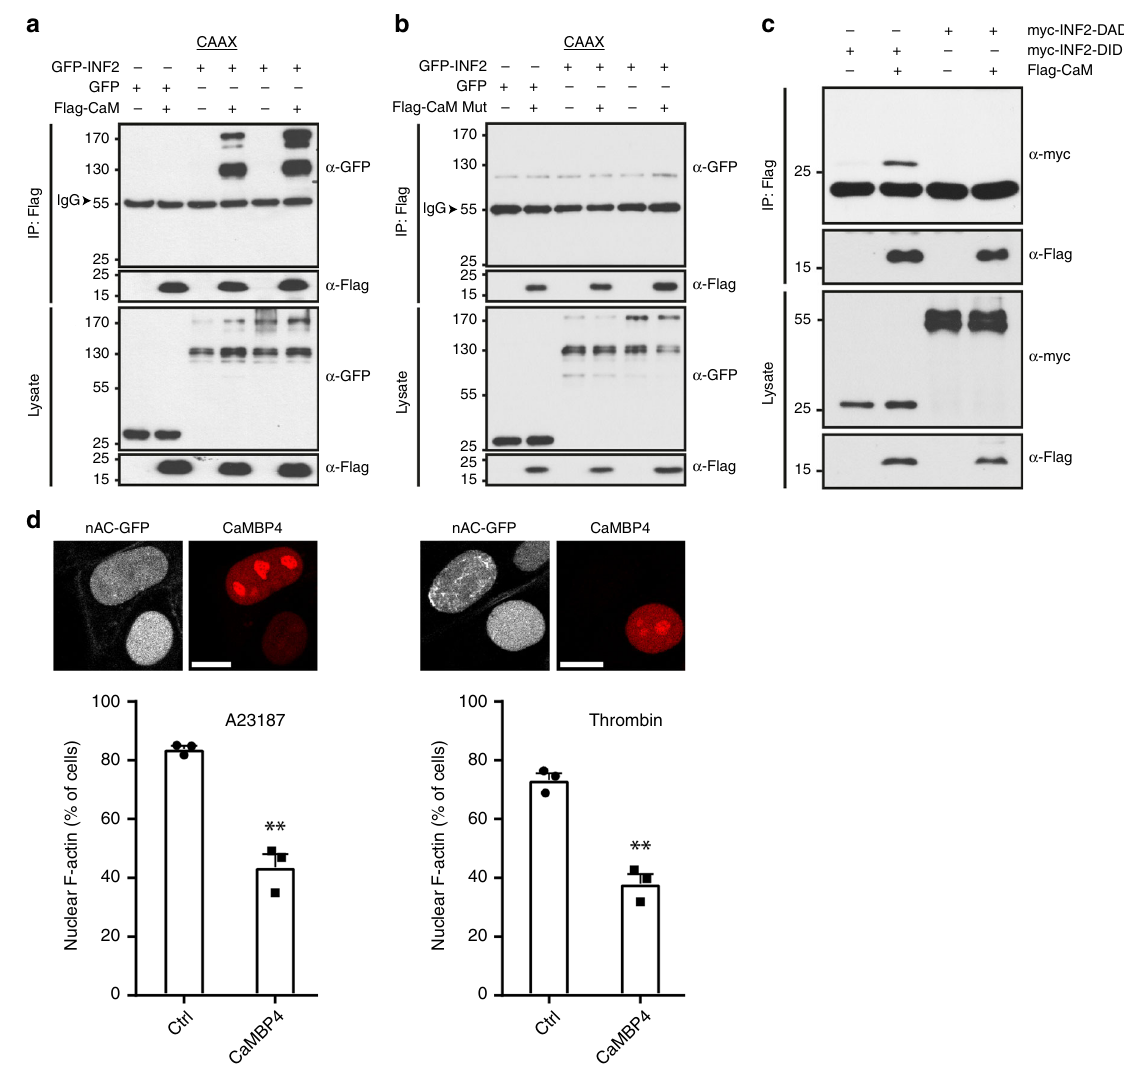
Fig. 4 INF2 interacts with calmodulin and Ca 2 + /CaM-INF2 plays a role in NAA. a Immunoprecipitations of HEK293 cells expressing Flag-calmodulin (CaM) and GFP-INF2. Associated INF2 was detected using anti-GFP antibodies. b Immunoprecipitations of HEK293 cells expressing Flag-CaM-mut (calcium-binding mutant) and GFP-INF2. Associated INF2 was detected using anti-GFP antibodies. c Immunoprecipitations of HEK293 cells expressing Flag-CaM and myc-INF2-DID or DAD (Diaphanous Autoregulatory Domain). Associated INF2 was detected using anti-myc antibodies. d Cells stably expressing nAC-GFP were transfected with mCherry or nuclear CaM inhibitor mCherry-CaMBP4. Cells were stimulated with A23187 or thrombin and counted for the formation of nuclear F-actin. n = 3 independent experiments. Two-sided Student's t test, ** p ≤ 0.01. Error bar: + s.e.m. Representative images are shown above. Scale bars: 10 μ m. Source data are provided as a Source Data fi